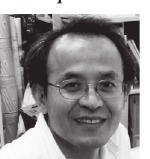
Figure 1 | Structure of the cerebellum and cerebellar molecular layer in mice. (A,B) Schematic illustration of the structure of the cerebellum in mice. (A) Parasagittal view of mouse cerebellum. The boxed region (upper right) is magnified. wm, white matter; ml, molecular layer; PCl, Purkinje cell layer; gcl, granule cell layer; DCN, deep cerebellar nucleus. Figures are modified from Allen Mouse Brain Atlas [Internet]. Seattle (WA): Allen Institute for Brain Science. ©2008. Available from: http//www.brain-map.org. (B) Cell bodies of Bergmann glial cells (BGC) are localized in the Purkinje cell layer (PCl), where somata of Purkinje cells (PC) align. In the molecular layer (ml), BGC processes associate closely with PC dendrites. Cerebellar astrocytes (AC) are present in the granule cell layer (gcl) and white matter (wm). (C,D) Double immunofluorescence analysis of parasagittal sections of the cerebellum from Cx43 fl/ + mice (1.5-month-old) that served as controls in Tanaka et al. (2008). (C) GFAP (green)-positive BGC processes show intimate structural relationships with calbindin-D (red)-positive PC dendrites in the molecular layer. Modified and reproduced from